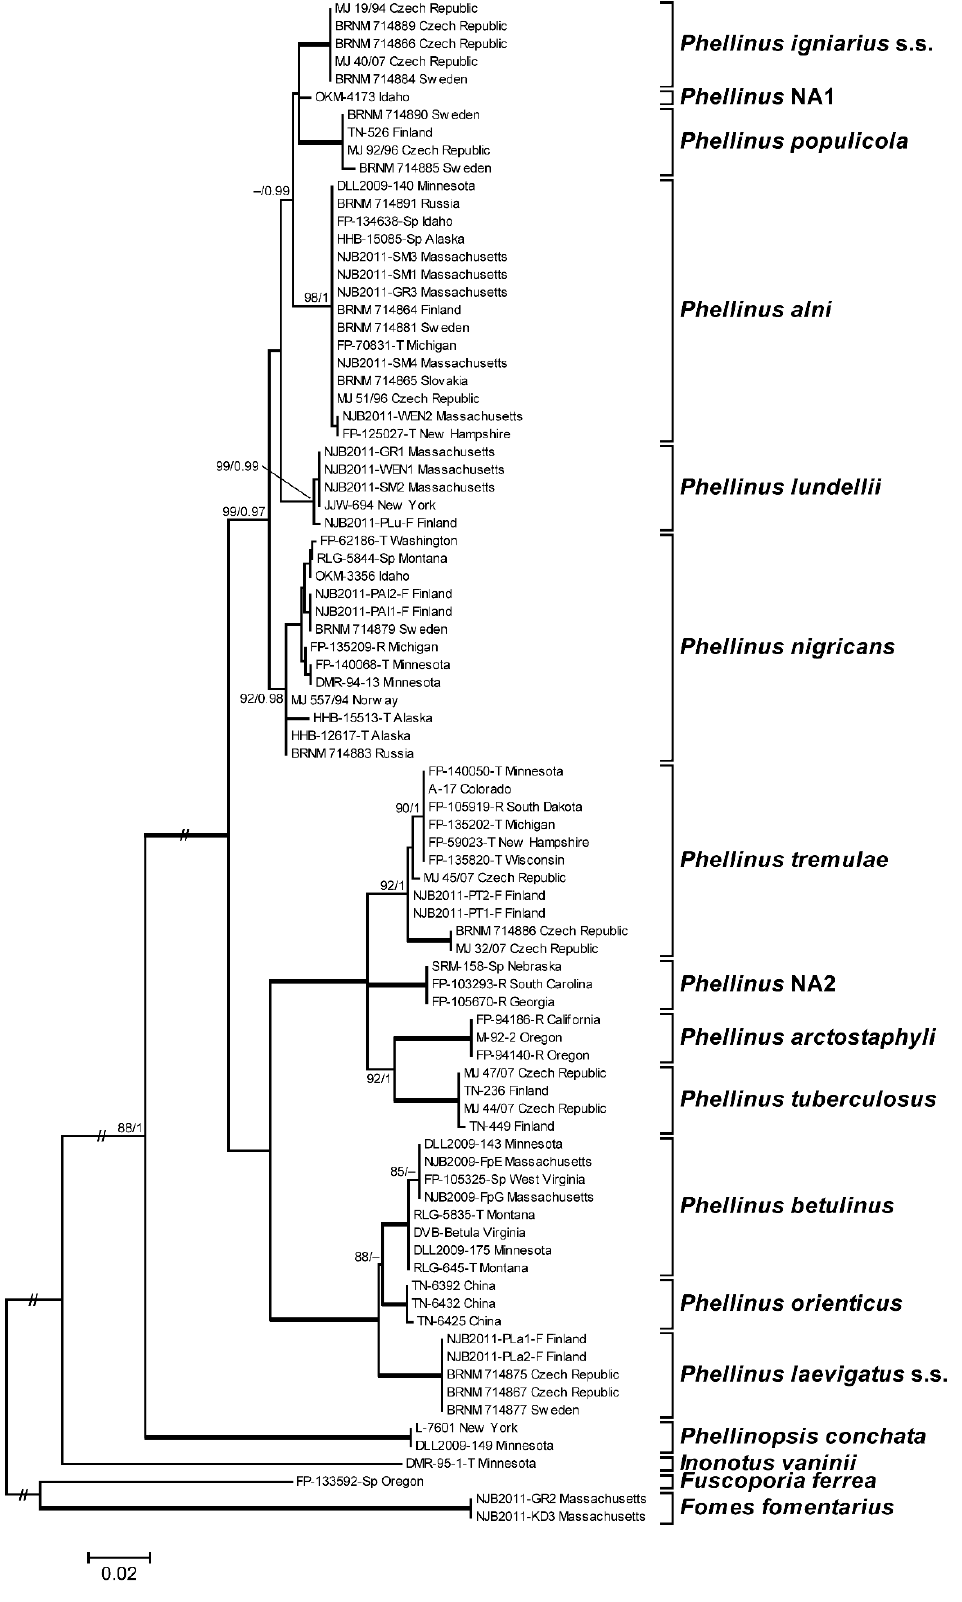
Figure 4. Maximum likelihood tree based on tef1 sequences of Phellinus s.s. species. Bootstrap support values ≥70% and PP values ≥0.95 are shown next to the nodes. Thickened branches represent BS/PP values